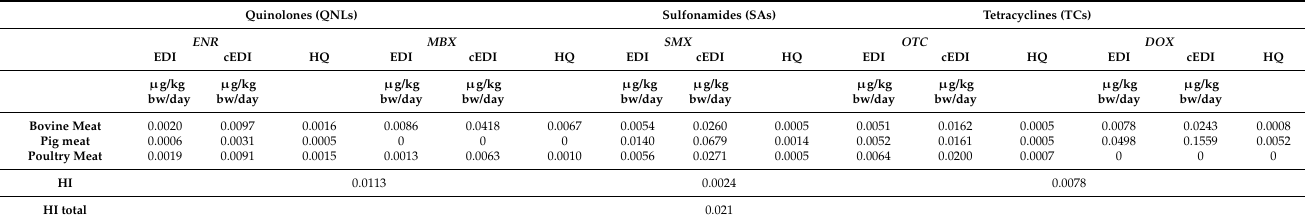
Table 6. Estimation of the corrected exposure(cEDI) and hazard quotients (HQs) by LC-MS detected levels (DL), ADIs and calculated CFs *.